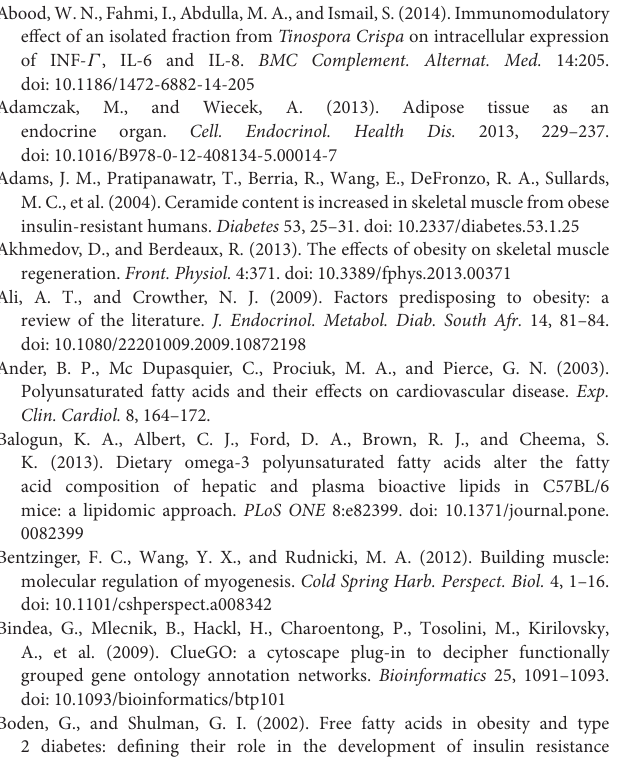
Supplement 3.1 | ID’s, gene name, description and significance levels of fat metabolism microarray analysis. Red = p ≤ 0.05; Green = p ≤ 0.01. Supplement 3.2 | ID’s, gene name, description and significance levels of Notch, Insulin, Sonic hedgehog and Apoptosis microarray analysis. Red = p ≤ 0.05; Green = p ≤